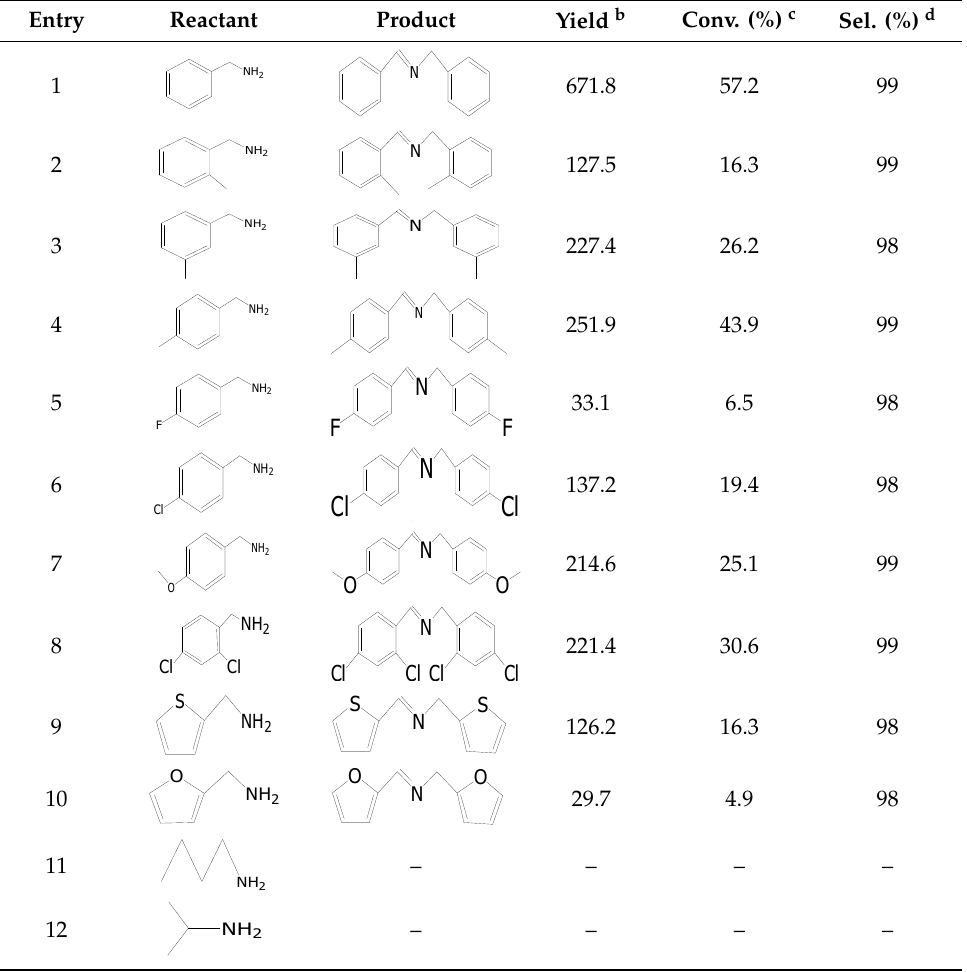
Irradiation time (h) b Figure 6. ( a ) Influence of irradiation time on conversion of benzylamine and selectivity of corresponding imine with CuW 0.7 Mo 0.3 O 4 (x = 0.7); ( b ) yields of CH 3 OH production as a function of irradiation time. Motivated by preceding results, the substrate scope of the oxidation of other amines to corresponding imines coupling with the reduction of CO 2 to CH 3 OH with photocatalytic CuW 0.7 Mo 0.3 O 4 (x = 0.7) was also carried out. Detailed results, shown in Table 3, show that the oxidative coupling reactions of the amine derivatives to their corresponding imines coupling with the formation of CH 3 OH from CO 2 could proceed well under the same conditions. However, different substrates can present great differences in the conversion of amines and the yield of CH 3 OH. Methyl-substituted benzylamines at the o -, m -, and p - positions of the benzene ring (Table 3, entries 2–4) can also be converted, but there are slight differences in the conversion process, and it can been seen from the Table 3 that their conversion rates differ vary greatly, which might to be relative to the effect of the steric hindrance. It can be ascribed to the electronic effects associated